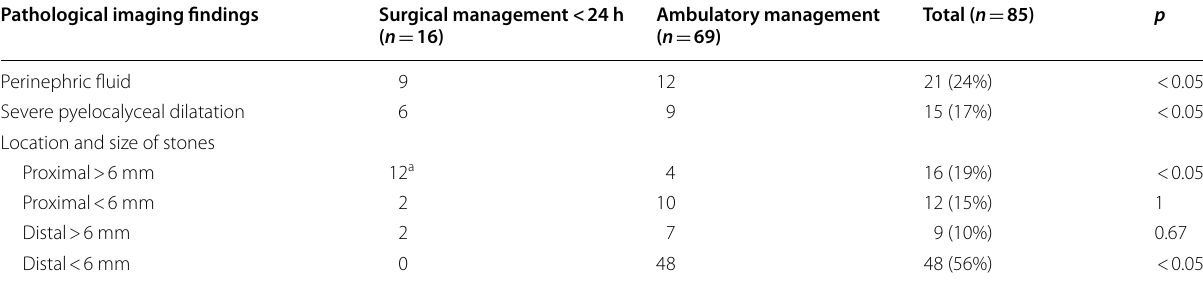
a Three patients who initially received ambulatory treatment were readmitted within 48 h and underwent surgical treatment